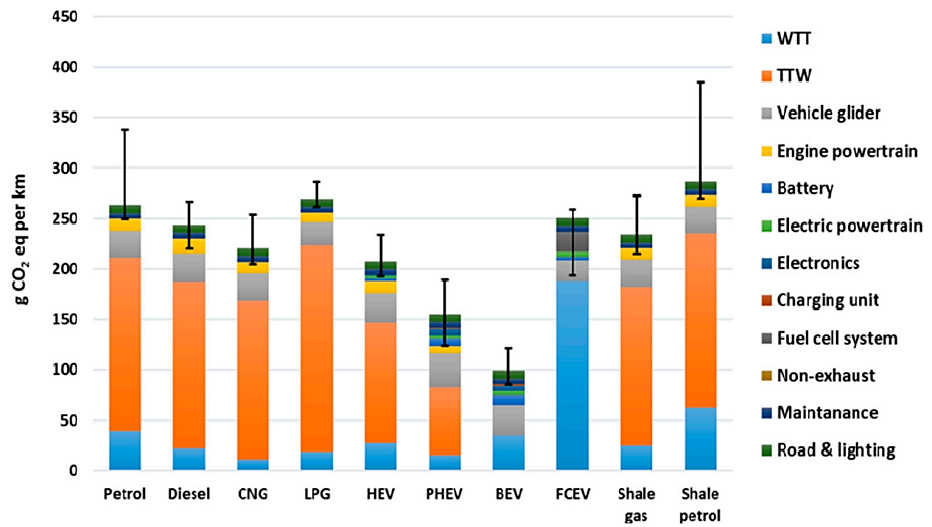
Figure 9. Results of the life cycle assessment (LCA) for climate change [8].